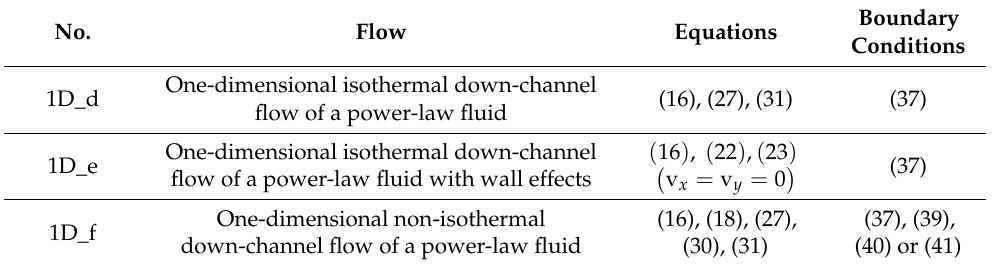
Boundary Conditions